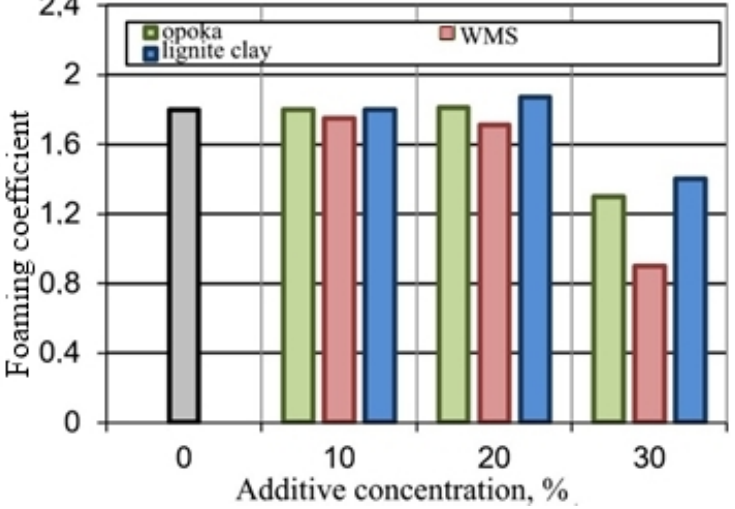
Figure 8. Influence of additives on the foaming of the glass mass.